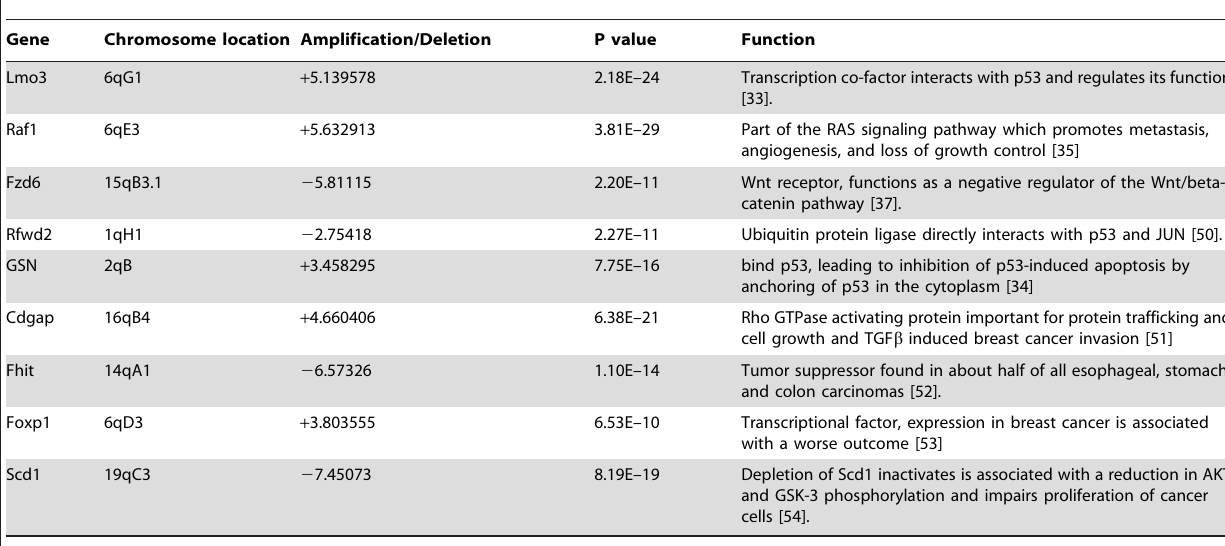
Table 1. Genes that were modified in colon of DMH-treated ICAD 2 / 2 mice compared to untreated mice.